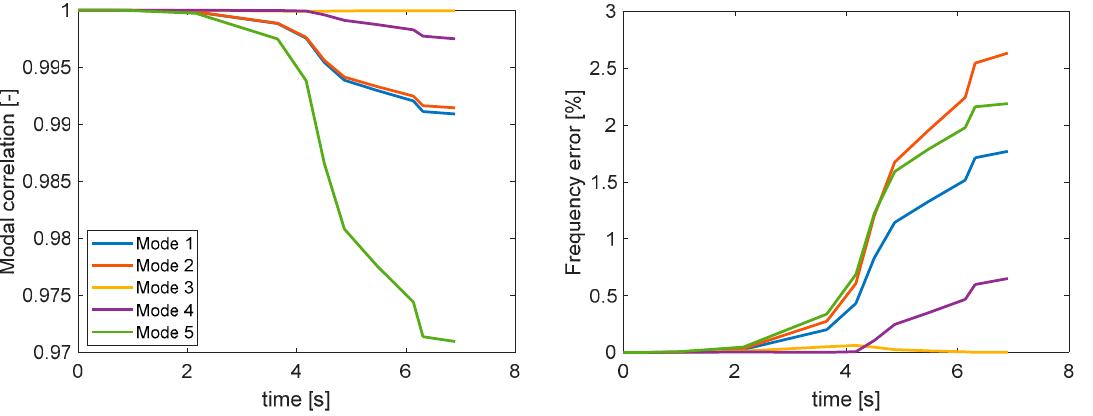
Figure 35. Modal correlation between time-varying SVD method and the eigenmodes ( left ) and the natural frequency error ( right ).